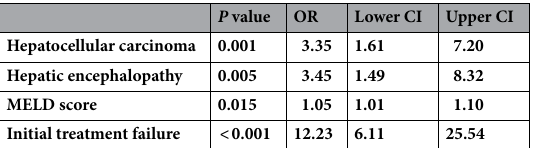
Table 6. Factors associated with 30-day mortality (Multivariate analysis). Significant values are in [bold].